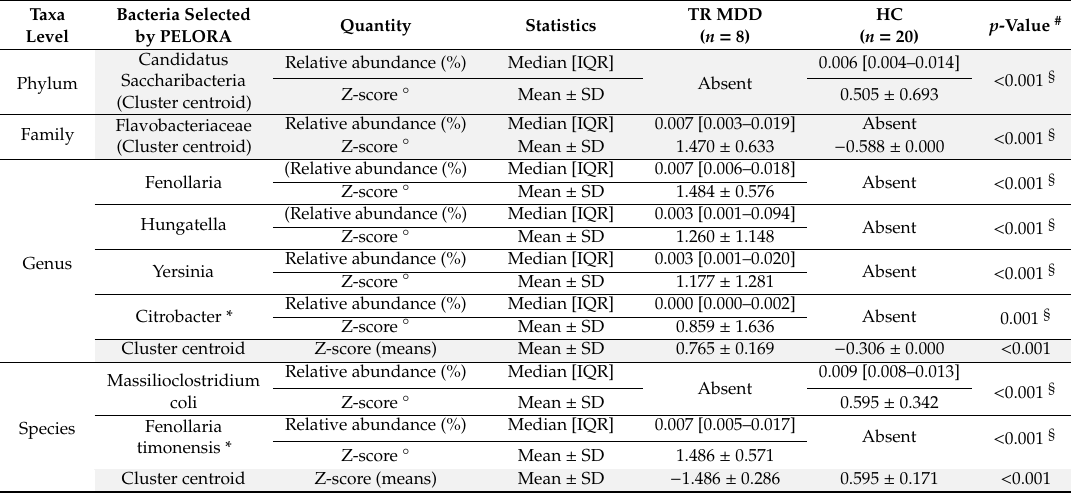
Table 6. Results from the penalized logistic regression analysis (PELORA) algorithm which identifies pathways of bacterial populations that best discriminate treatment-resistant (TR) DDM patients from healthy controls